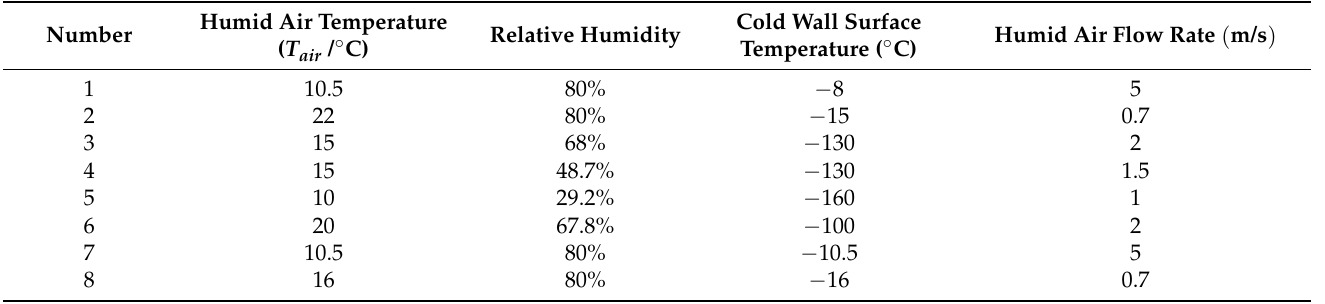
Table 1. Flat plate frosting calculation parameters.